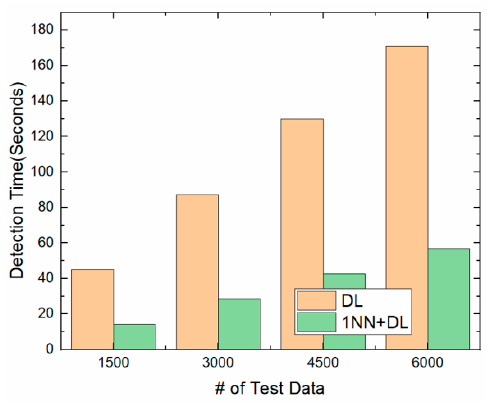
Figure 11. Detection times.